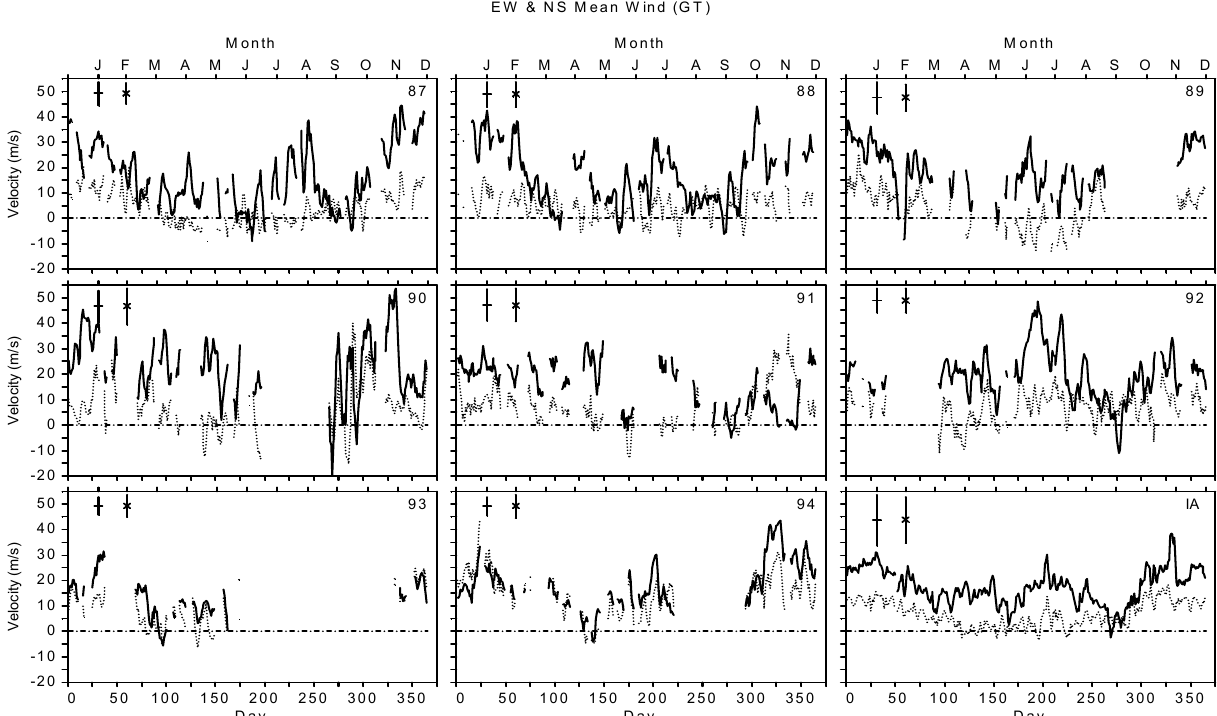
Fig. 2. The zonal (solid line) and the meridional (dotted line) mean winds for the years 1987–1994 and for the corresponding 8-year interannual average (IA). The maximum error (one standard deviation of the mean) for each series is shown at the top left-hand corner with symbol − and × , representing the zonal and the meridional series,